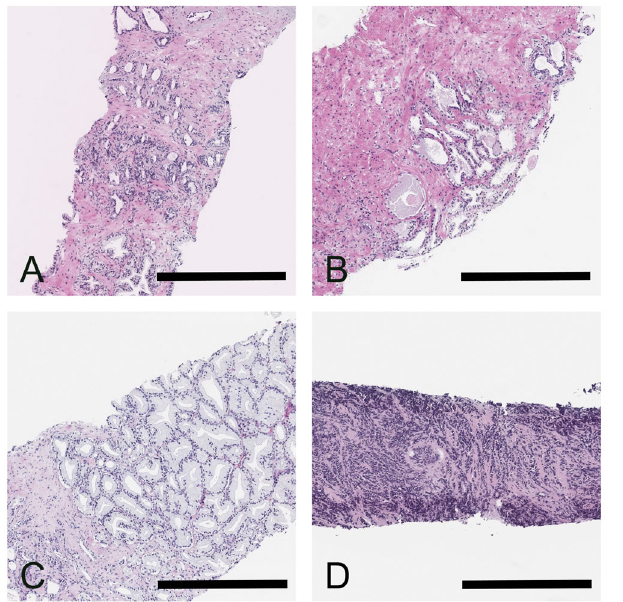
Fig. 3 | Example pathology imagesofrare prostate tissue subtypes. Panel A Be- nignprostatictissuewithpostatrophichyperplasia.Panel B Benignprostatictissue with partial atrophy. Panel C Pseudohyperplastic cancer. Panel D Small cell carci- noma of the prostate. The case in Panel B was misinterpreted by AI as malignant, while the other cases were correctly classi fi ed as benign and malignant, respec- tively. Scale bars correspond to 500 µ